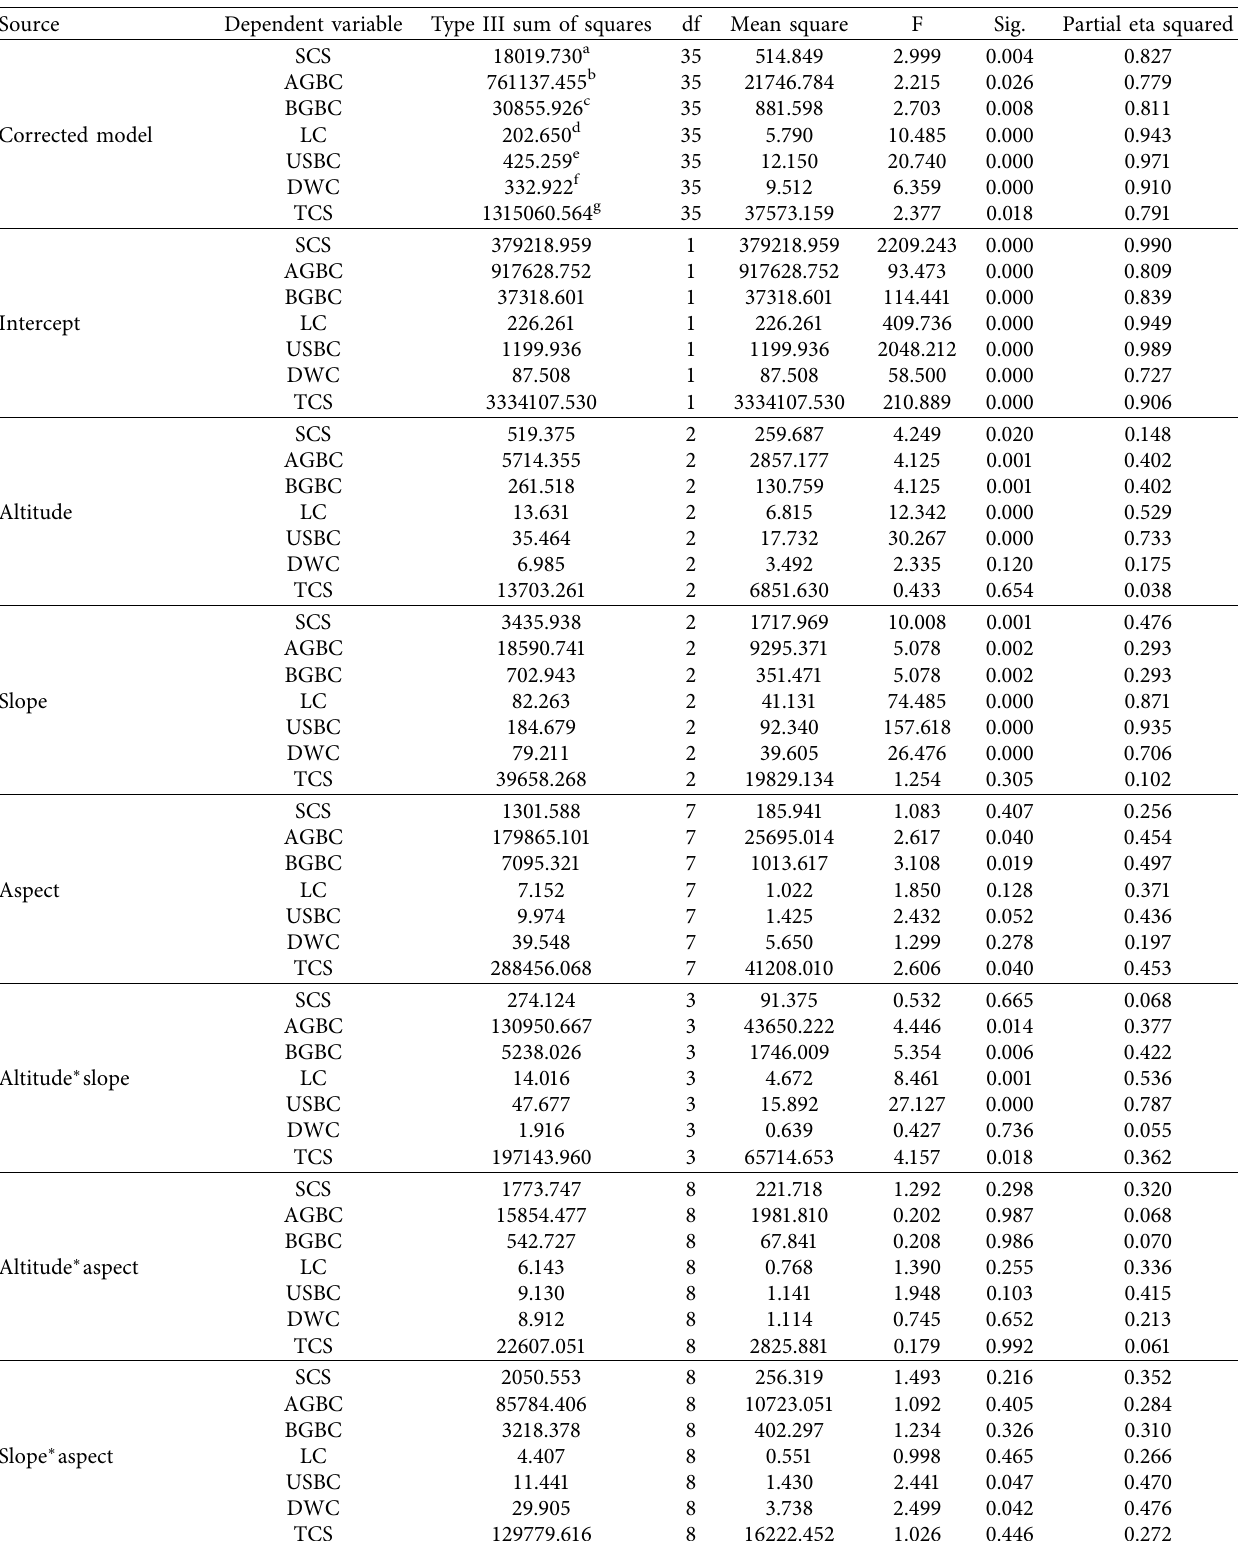
Table 7: Tests of between-subject effects in Anshirava